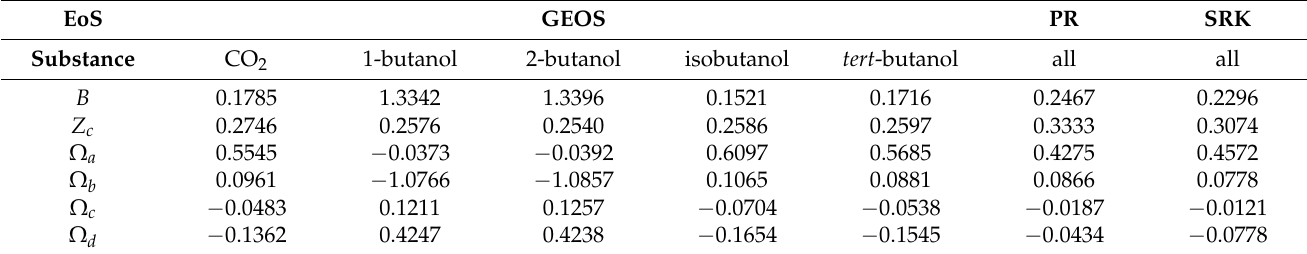
Table 9. The critical compressibility factor ( Z c ), and GEOS parameters ( Ω a , Ω b , Ω c , Ω d , B